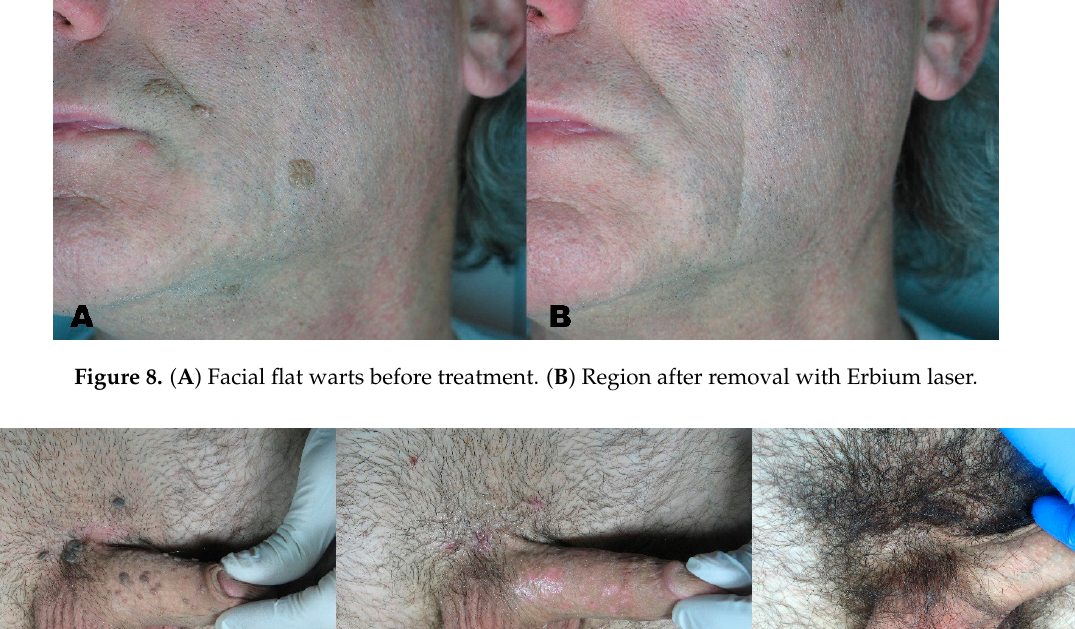
Figure 7. ( A ) Seborrheic keratosis before treatment. ( B ) Region after removal with Erbium laser.